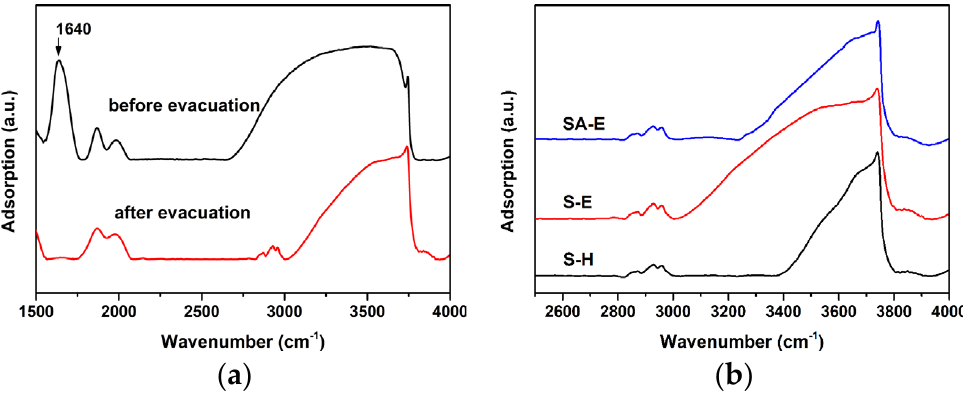
Figure 6. FTIR spectra of Sample S - E before and after the evacuation under vacuum ( a ); FTIR spectra of Samples S - H and S - E after evacuation under vacuum ( b ).